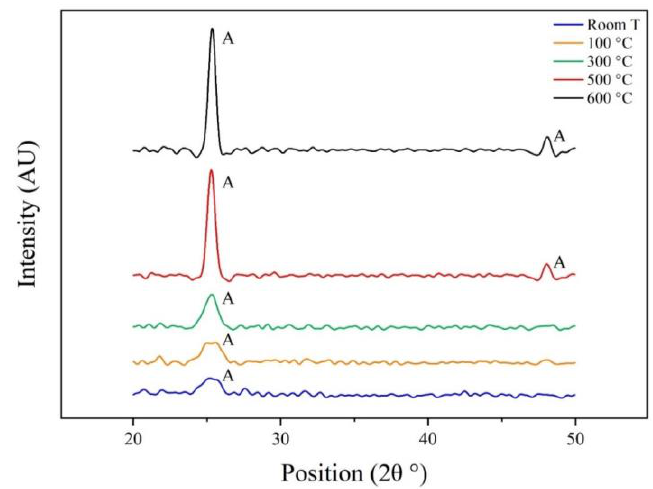
Figure 2. XRD patterns of coatings annealed at different temperatures.